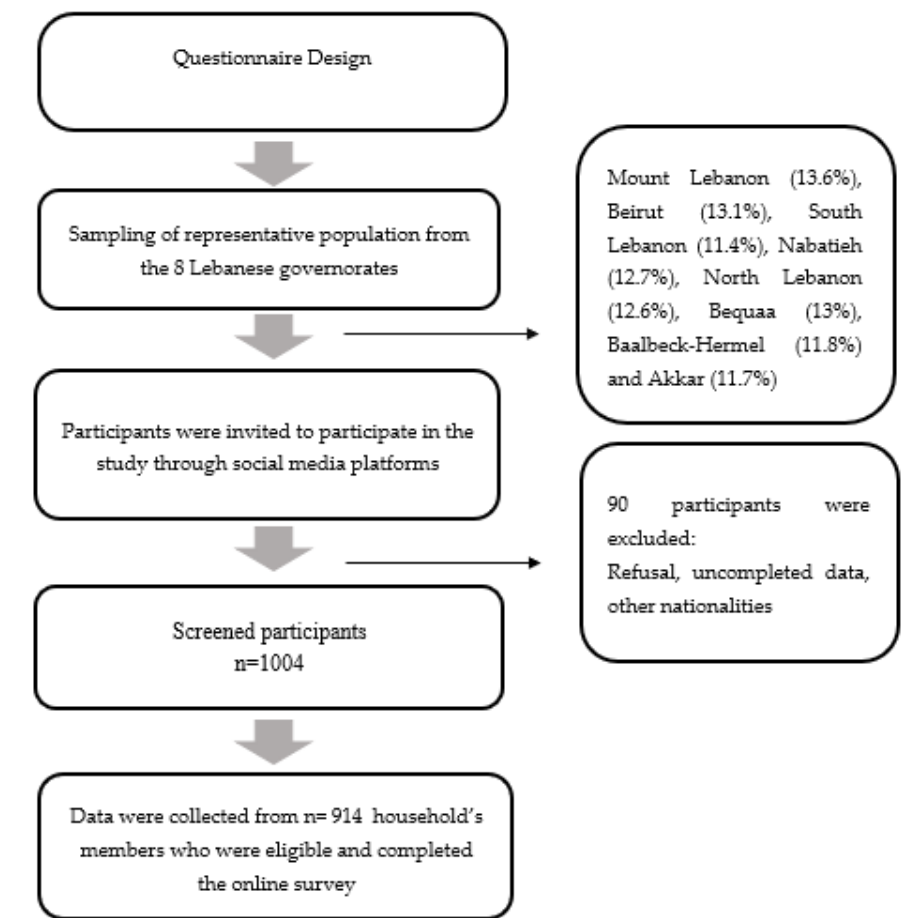
Figure 1. Flow Chart of the Recruitment Process in the Study.